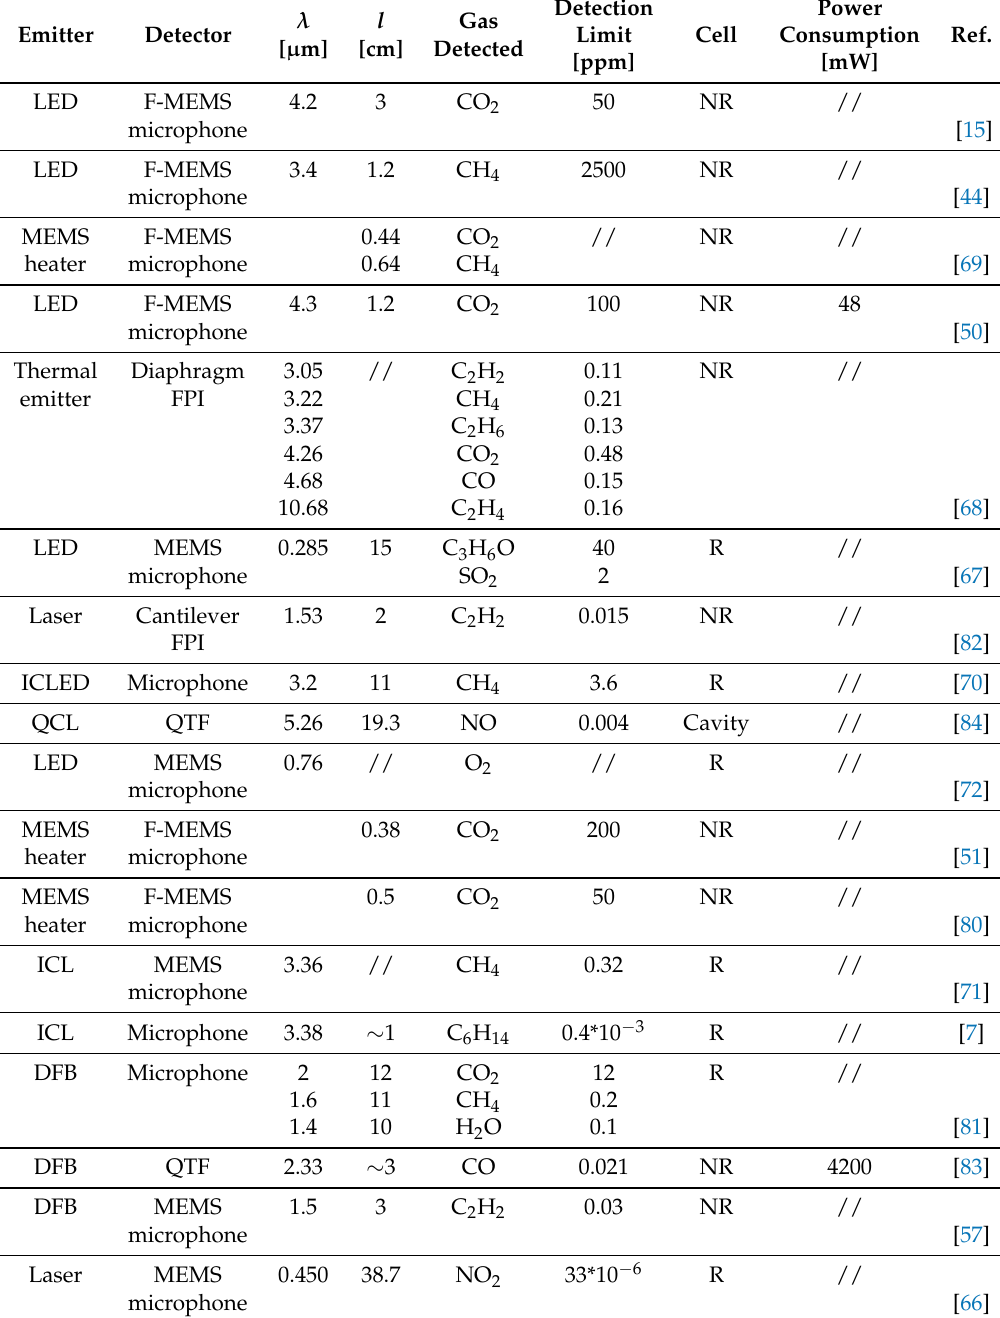
Table 2. Gas sensors based on acoustic detection. F-MEMS: gas filled-MEMS; FPI: Fabry–Pérot interferometer; ICLED: interband cascade light emitting device; QTF: quartz tuning fork; ICL: interband cascade laser; NR: non-resonant; R: resonant; //: unreported; CO 2 : carbon dioxide; CH 4 : methane; C 2 H 2 : acetylene; C 2 H 6 : ethane; CO: carbon monoxide; C 2 H 4 : ethylene; C 3 H 6 O: acetone; SO 2 : sulfur dioxide; NO: nitric oxide; C 6 H 14 : hexane; O 2 : oxygen; H 2 O: water; NO 2 : nitrogen